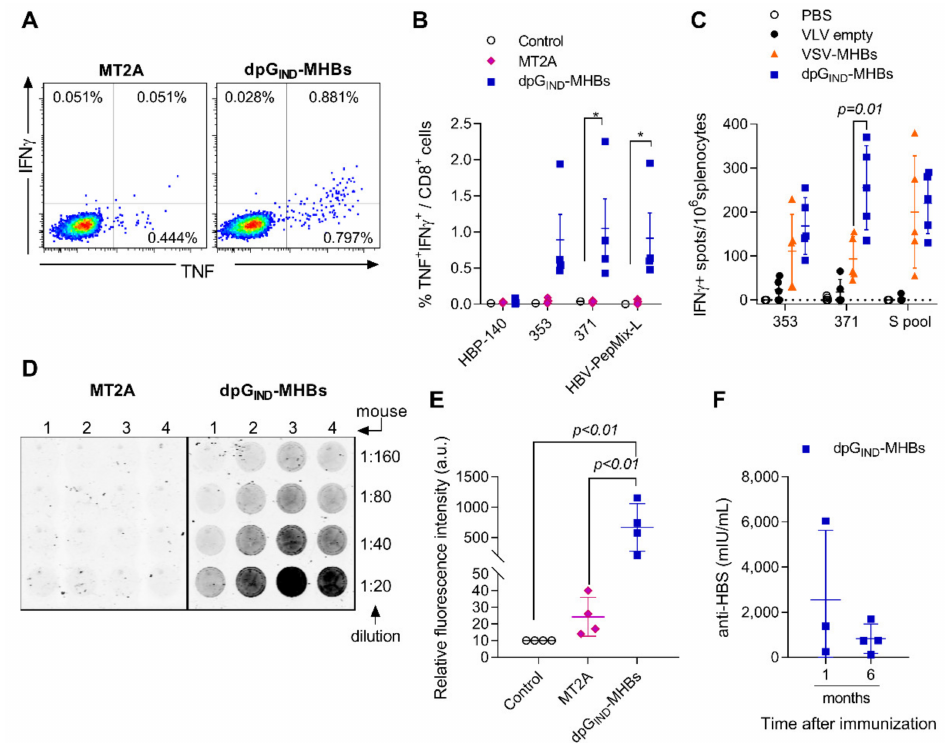
Figure 2. MHBs expression with dp VLV enhances MHBs immunogenicity in naïve mice. C57BL / 6 male mice were immunized with 1 × 10 8 PFU / mouse MT2A or dpG IND -MHBs to analyze splenic e ff ector T cell and antibody responses. ( A ) Representative dot plots showing intracellular staining for TNF and IFN- γ in gated CD8 + T cells after re-stimulation with HBS-371 peptide. ( B ) Frequency of TNF + IFN γ + cells among CD8 + T cells at day 7 post-immunization measured by intracellular staining and flow cytometry after re-stimulation with the indicated peptides or peptide pool. ( C ) Frequency of IFN γ + cells measured by ELISPOT after re-stimulation with the indicated peptides or peptide pool at day 14 post-immunization with empty vector VLV, dpG IND -MHBs, or VSV-MHBs. VSV-MHBs was used at 1 × 10 6 PFU / mouse by the i.m. route of immunization. ( D ) Detection of anti-HBs antibodies using solid-phase absorbed HBsAg. Dilutions of mouse serum samples collected at 1 month after immunization and fluorescently conjugated anti-mouse secondary antibody. ( E ) Quantification of the signal from the anti-HBs assay at the 1:20 dilution of the serum samples. ( F ) Measurements of anti-HBs antibodies at 1 month and 6 months post-immunization with dpG IND -MHBs. * p < 0.05, relative to control